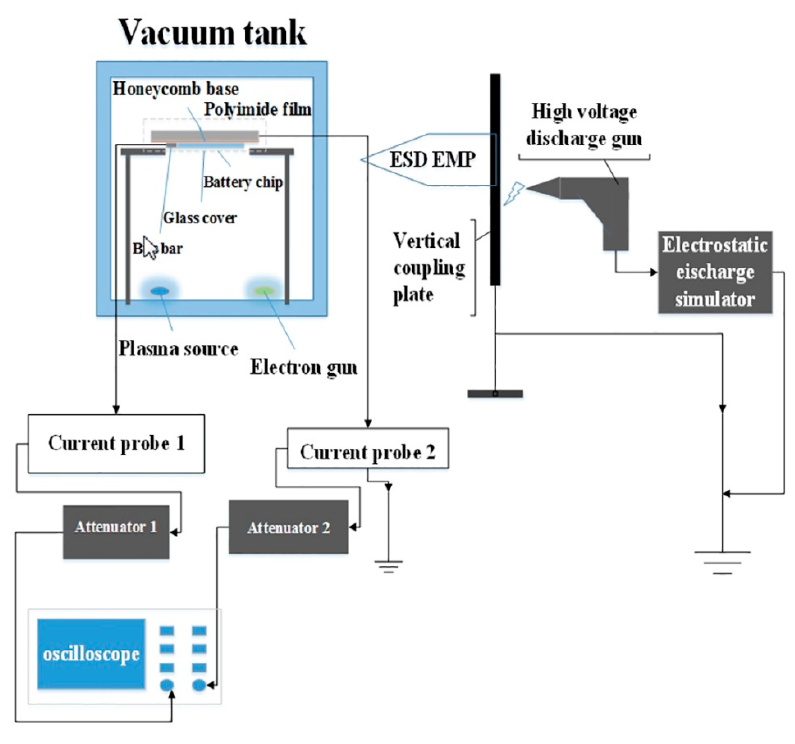
Figure 2. Test diagram of electrostatic discharge of solar array induced by ESD EMP.